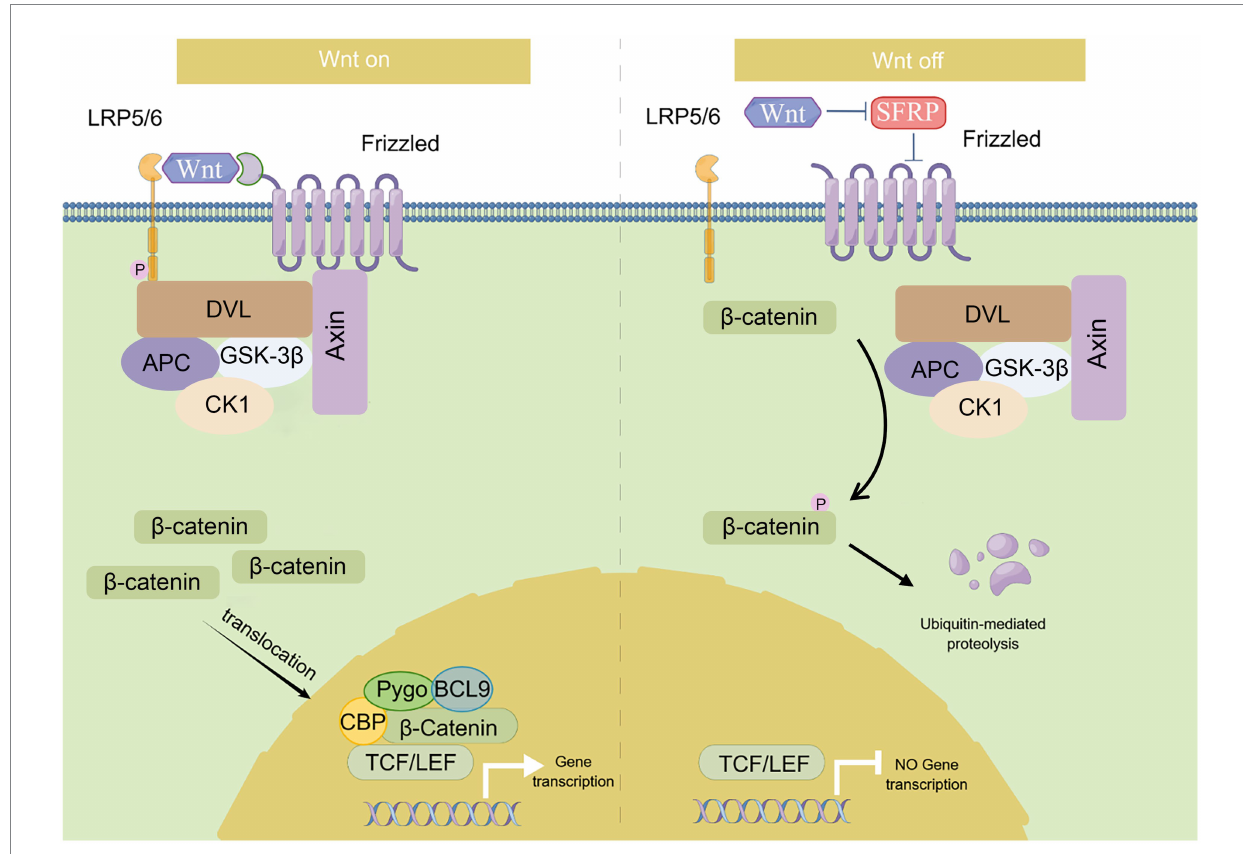
FIGURE 1 Summary of Wnt/ β -catenin signaling pathway. This diagram depicts the canonical Wnt/ β -catenin signaling pathway. Wnt/ β -catenin signaling is activated (on-state) in the presence of Wnt ligand, which binds to Frizzled receptor and LRP5/6, and recruits Dishevelled (DVL) which restrains the destruction complex (GSK-3 β , CK1, Axin, and APC) to formulate. β -catenin is accumulated in the cytoplasm and translocates into the nucleus where it facilitates gene transcription as a co-activator of LEF1/TCFs. While in the absence of the Wnt ligand (off-state), this signaling pathway is inactivated. β -catenin is phosphorylated by the destruction complex and then ubiquitinated by the SCF (Skp1/cullin/F-box) complex for proteasome